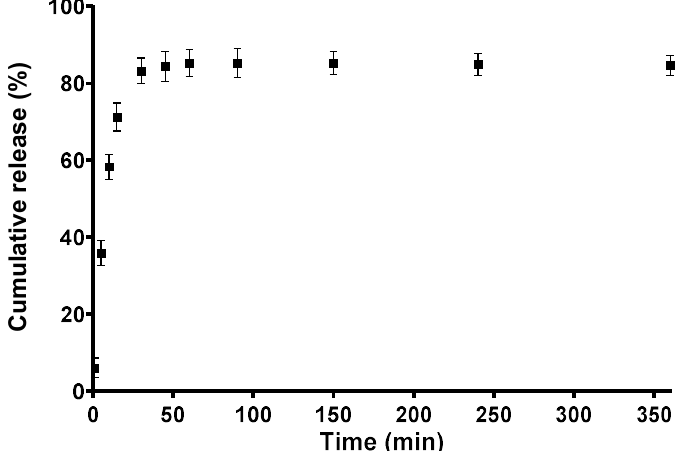
Figure 6. QUE release profile from CA/PEG/QUE fibers. The results are presented as average values from three separate measurements with the respective standard deviation; acetate buffer/Tween 80 (99.2/0.8 v/v ), pH 5.5, 37°C, ionic strength 0.1.